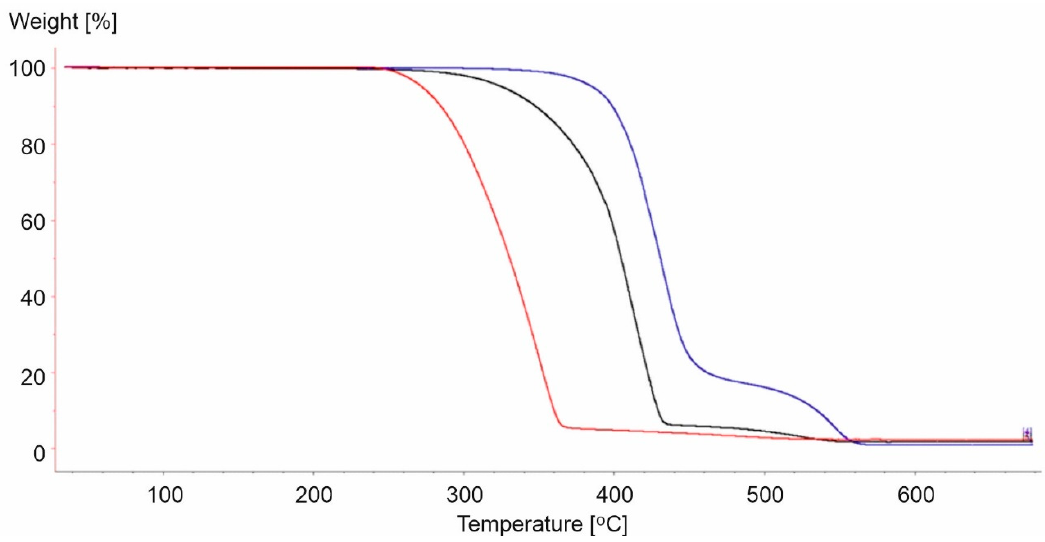
Figure 12. TG curves for PP ‐ 3 (red line), PS ‐ 1 (black line), and PET ‐ 1 (blue